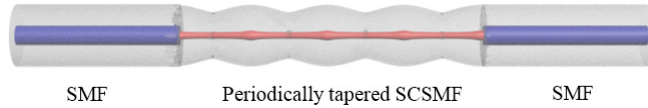
Figure 11. Schematic diagram of the SPTS fiber structure.